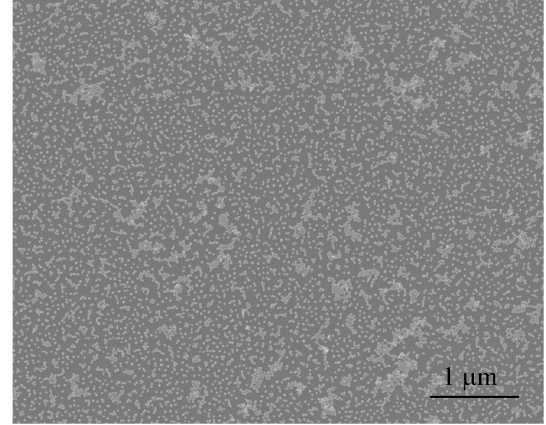
Figure 6. AuNPs on the flat Si surface. As AuNPs are much small than the hill structure of the rough surface of thin-film Ge, a flat surface is used to display the shape and size of the AuNP.